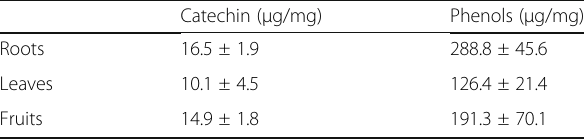
Table 2 Catechin and phenolics content in S. spinosum roots, leaves and fruits extracts (Average ±